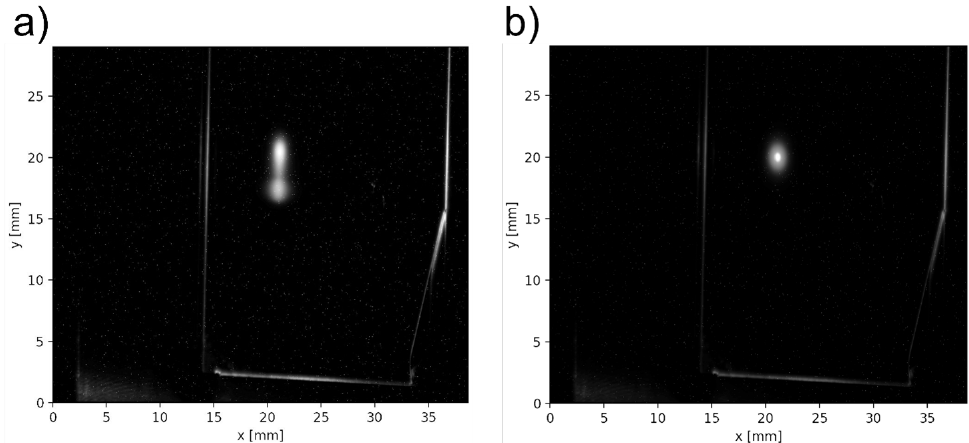
Figure 19. Scintillator screen (LYSO) captured by high resolution camera, downstream crystal station. ( a ) channeling is achieved, part of the beam is separated and deflected ( b ) in case the beam is not aligned with crystal, beam profile remains a single